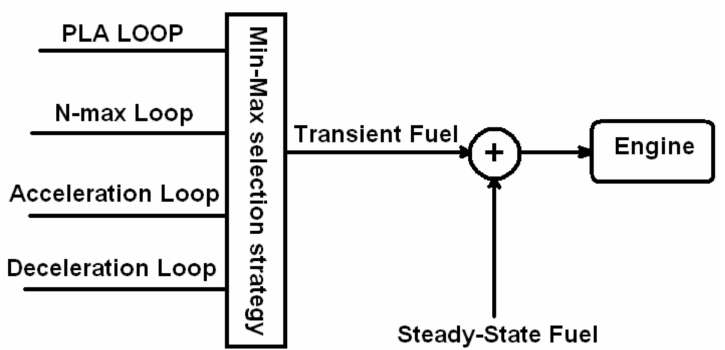
Figure 3. Schematic of a min–max control loop for a turbojet engine.